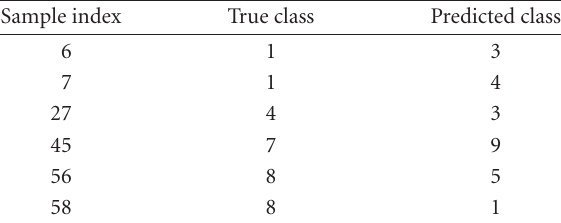
Table 6. Misclassifications of